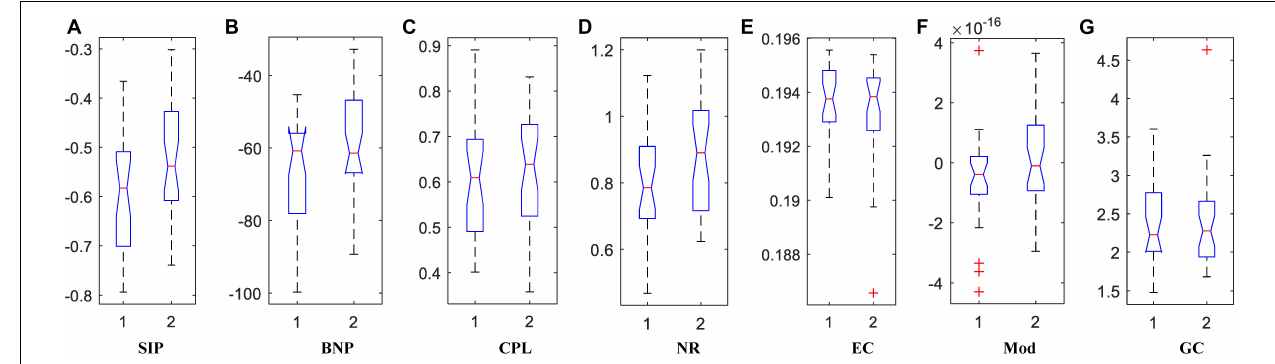
FIGURE 6 | The box plots of property values for APOE4 carriers (1) and non-carriers (2) groups using two persistent homology properties, (A) SIP and (B) BNP, and five graph-theoretic properties, (C) CPL, (D) NR, (E) EC, (F) Mod, and (G) GC.